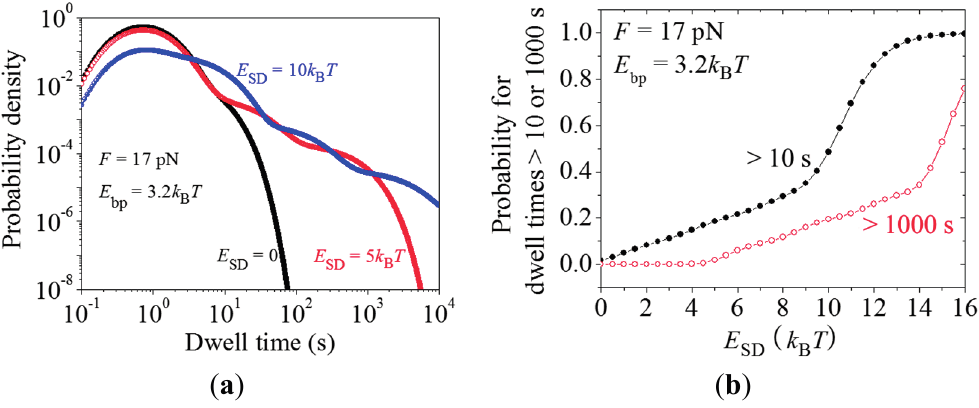
Figure 5. Dynamics of translation through the mRNA duplex in the presence of the interaction of the SD sequence with the anti-SD site of the 30S subunit. ( a ) Normalized distributions of dwell times, h ( t ), calculated with different values of the binding energy between SD and anti-SD, E SD , where F = 17 pN and E bp = 3.2 k B T ; and ( b ) Probability of pausing (>10 s) and probability of arrest (>1000 s) vs. E SD